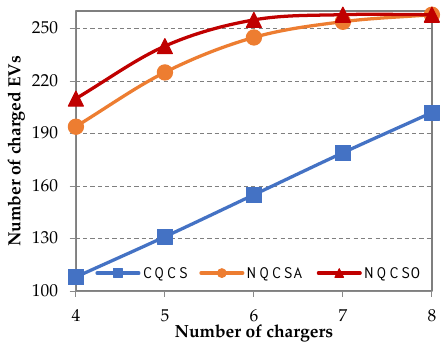
Figure 10. Number of charged EVs for a CS with different number of chargers in different charging